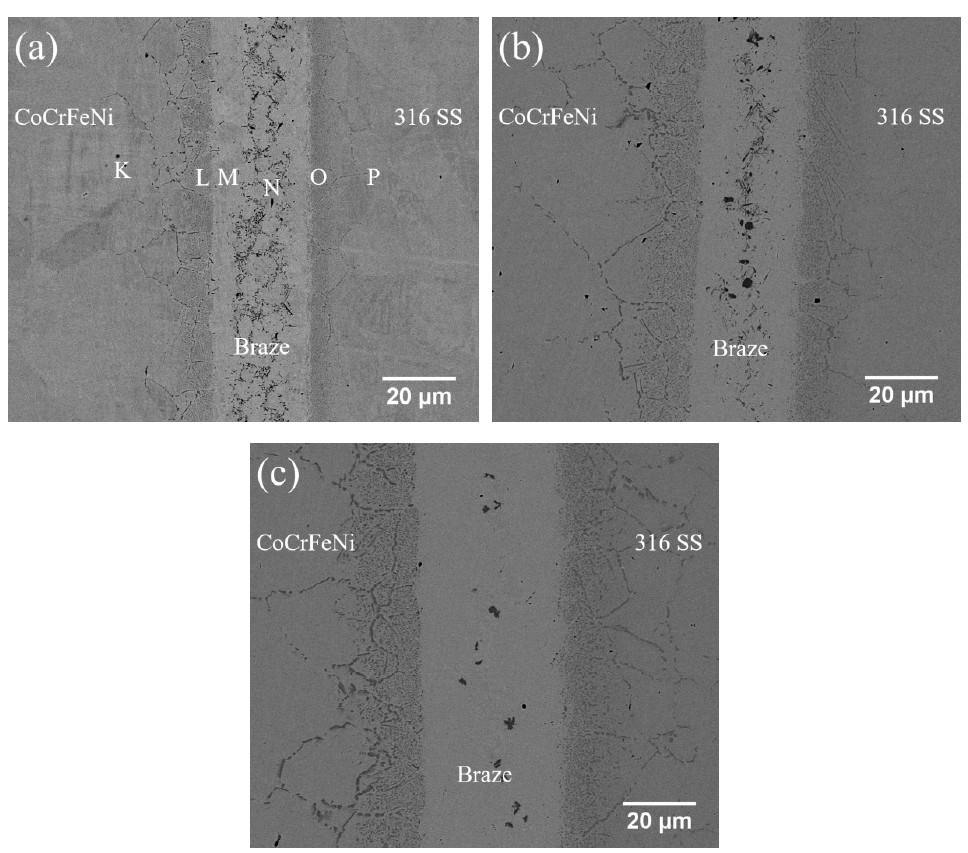
Figure 6. The BEIs of CoCrFeNi/BNi-2/316 SS joints infrared brazed at ( a ) 1020 °C for 180 s, ( b ) 600 s and ( c ) 1050 °C for 600 s.